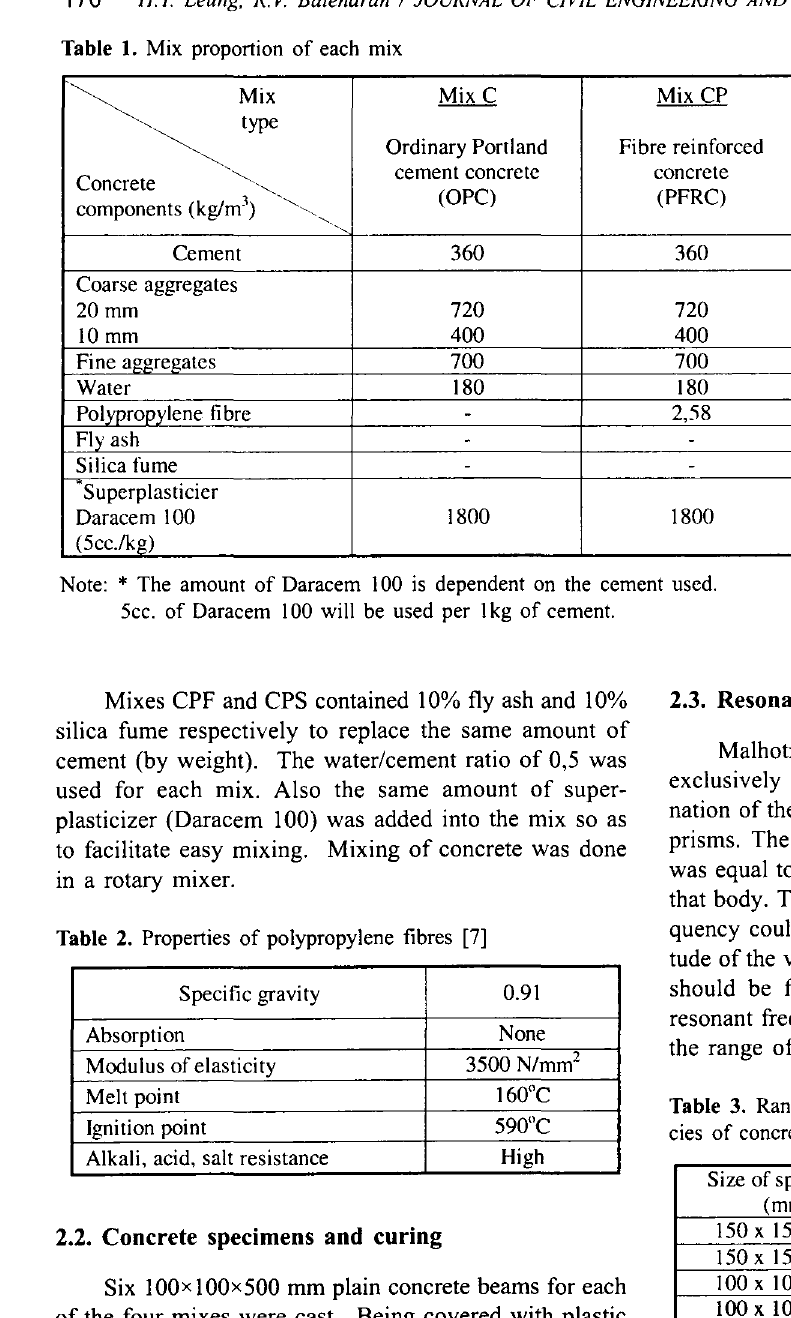
Table I. Mix proportion of each mix ~~-, Mix MixC MixCP type "~"- Ordinary Portland cement concrete